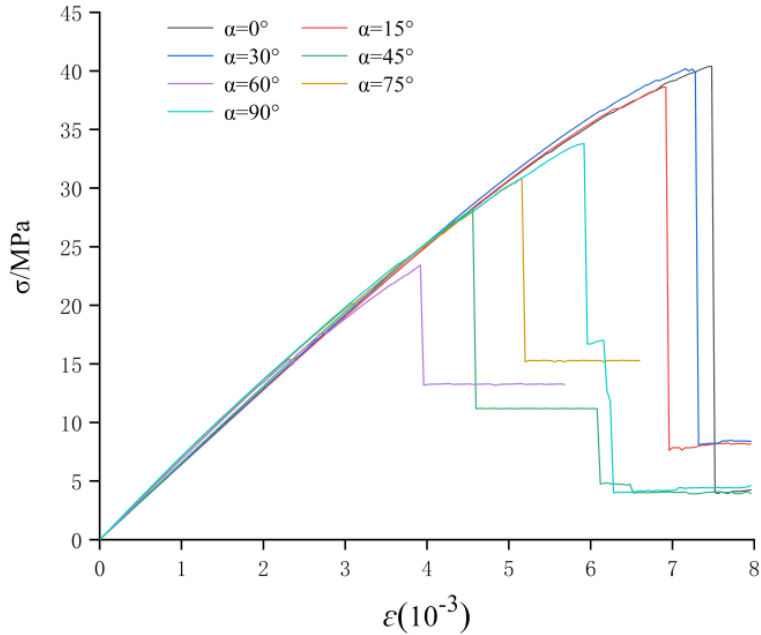
Appl. Sci. 2022 , 12 , x FOR PEER REVIEW 6 of 14